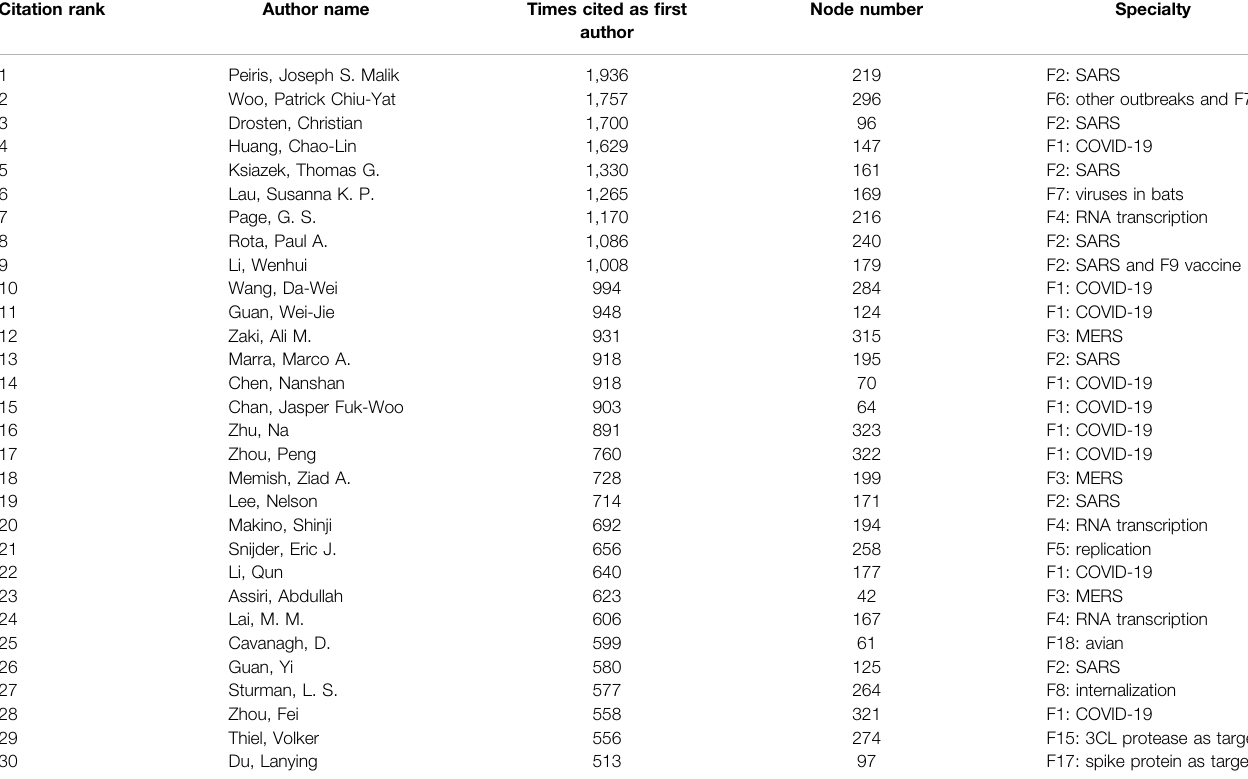
TABLE 2 | Top 30 highly cited authors examined with author cocitation